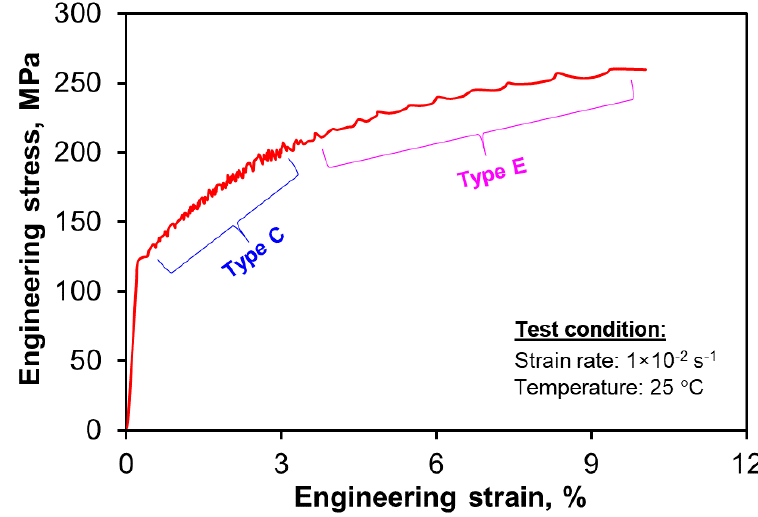
Figure 6. A typical tensile stress–strain curve of the alloy in the heat-treated condition.